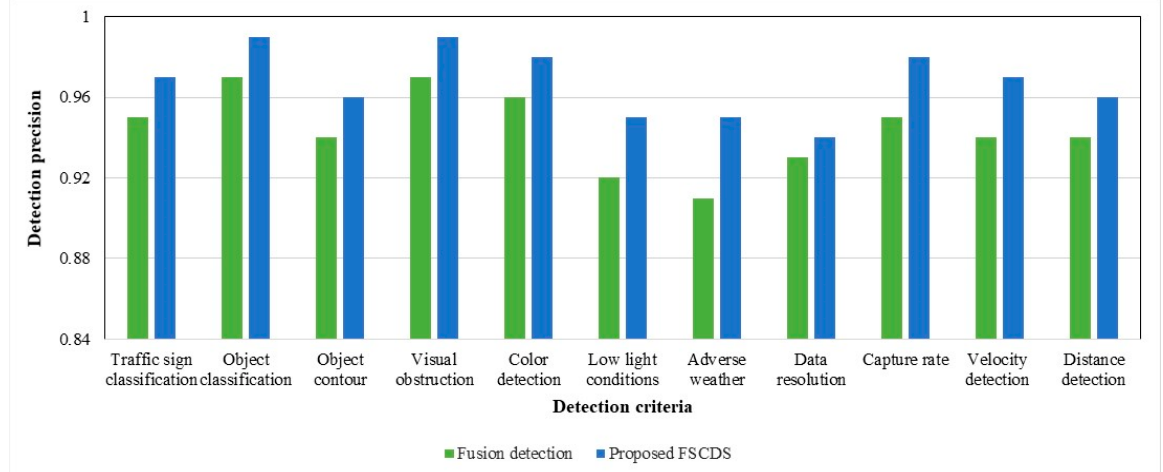
Figure 16. Detection estimation accuracy comparison of AV sensor fusion vs. proposed FSCDS approach.